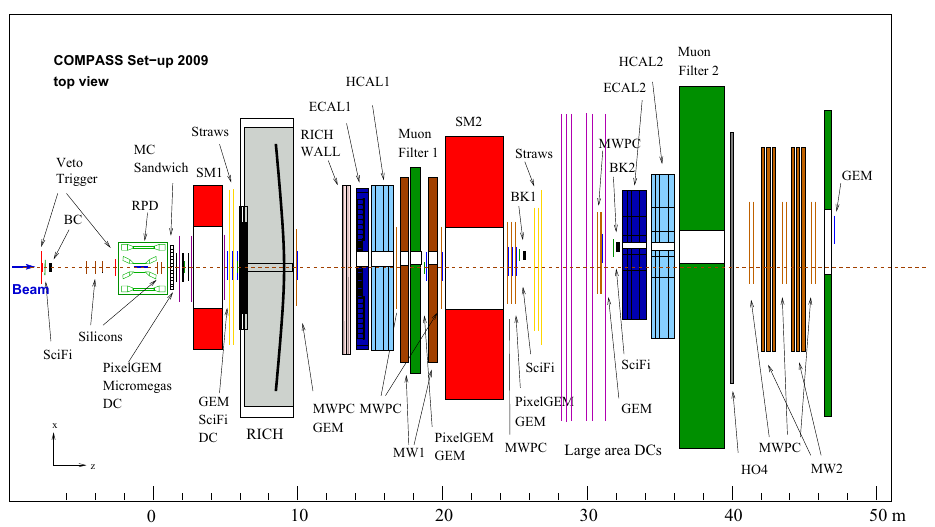
Figure 1. Layout of the COMPASS setup for hadron beam as used in the beam times of 2008 and 2009. A detailed description of the employed detectors is found e.g. in Ref. [1]. The spectrometer magnets SM1 and SM2, surrounded by tracking detectors and followed by the calorimeters, constitute the two stages of the